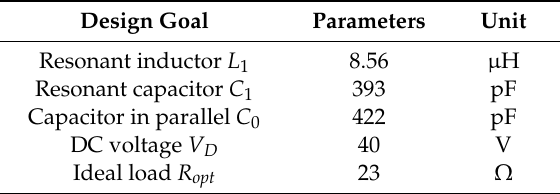
Table 2. Class E power amplifier parameters. Table 2. class E power amplifier parameters.